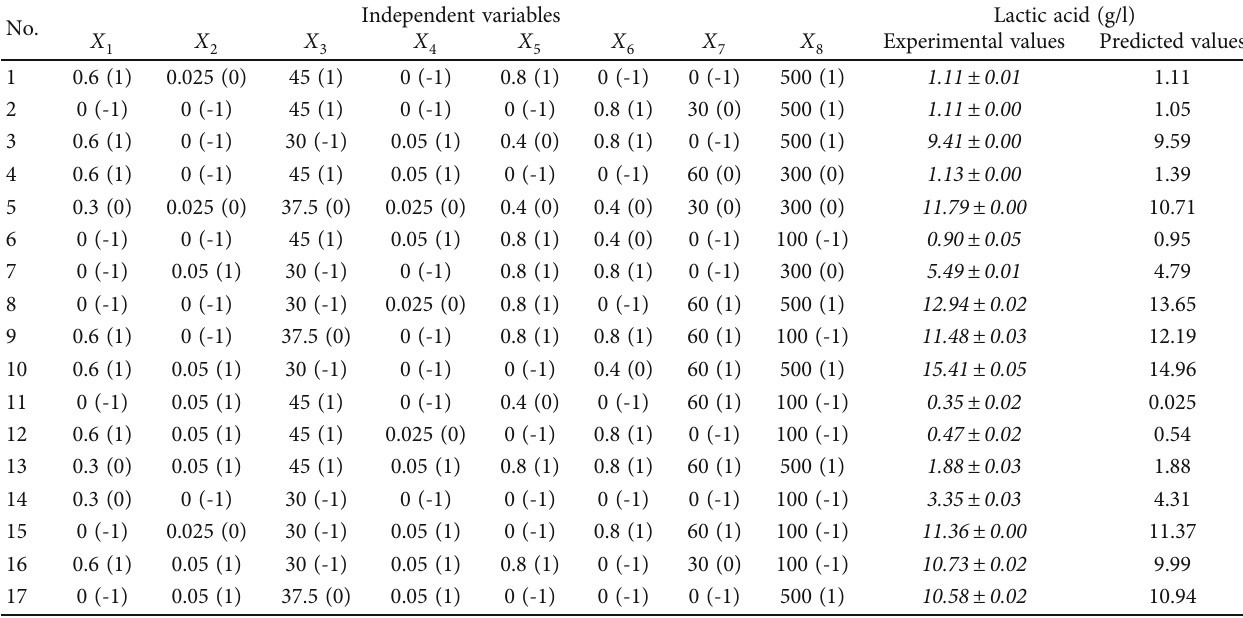
Table 2: De fi nitive plan design (real and coded values) with the respective results.